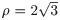
Pinwheel statistics in the Moiré interference model.
A Column spacing Λ estimated by the wavelet method compared to the Moiré scale Λc for different disorder strength. B The pinwheel density ρ as function of disorder strength. Dashed line shows theoretically predicted value ρ=23. Dark green line in inset shows experimentally observed mean value ρ = 3.14. C Pinwheel density in circular regions of increasing area for η = 0.12 (blue) and η = 0.02 (red). Lines show theoretically predicted and experimentally observed values as in B inset. D The standard deviation of pinwheel density estimates for increasing subregion size. Red line shows a power law fit to the experimental data (γ = 0.5, [23]), purple line indicates a fit to the perfectly ordered hexagonal pinwheel arrangement (γ = 0.75, [23, 92, 93]). E Nearest neighbor (NN) distances for pinwheels irrespective of topological charge. Left: distributions for two disorder strengths (η = 0.11, blue; η = 0.02, purple) and the experimental data (red). Right: Distributions for different disorder strengths. Color encodes the (normalized) fraction of pinwheels at this distance. Blue and purple lines indicate disorder strengths shown on the left. The white line marks the theoretically predicted distance of NN pinwheels (2/3Λc) for vanishing disorder [92, 93]. F same as E for pinwheels of equal charge, data green curve. G same as E for pinwheels of opposite charge, data blue curve. H squared deviation of NN distance distributions to the experimental estimates (shown in E-G, left) as function of disorder strength. All other model parameters as in Fig 3.